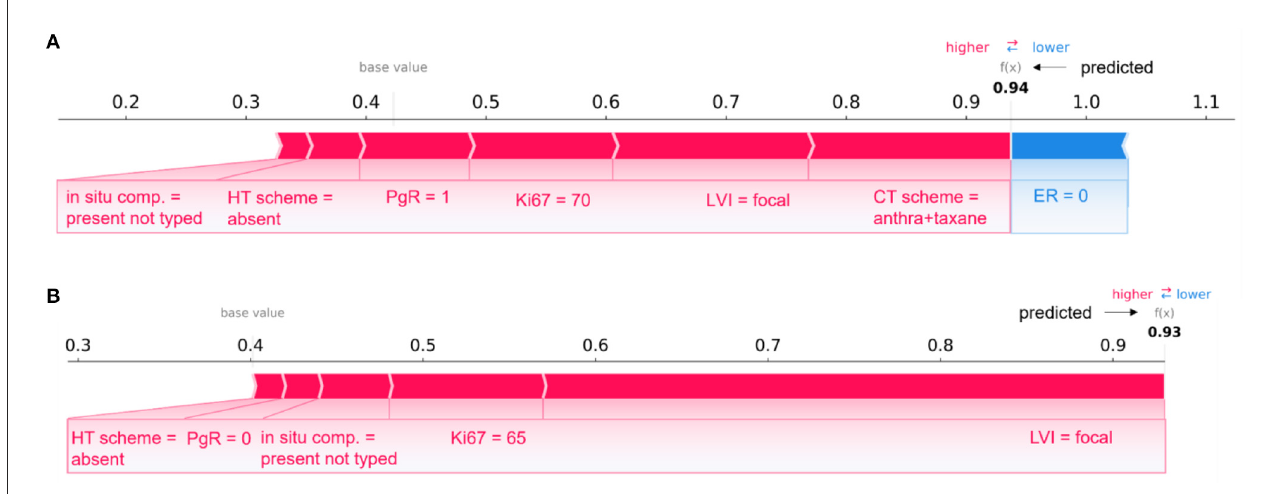
FIGURE7 Comparison of individual explanations between correctly and wrongly classified patients. (A) Patient correctly classified (IDE class) and (B) patient wrongly classified (real class: non-IDE; predicted class: IDE) by the 10-year predictive model. (A, B) Representation of the additive Shapley values: red color indicates a positive contributions, while blue a negative